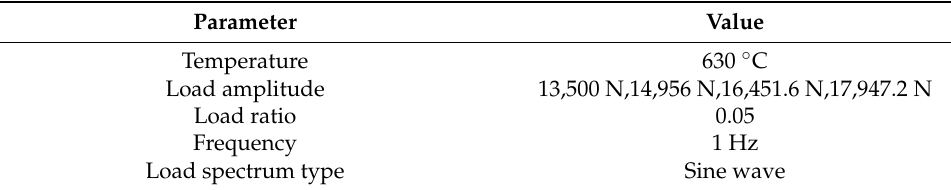
Table 3. Parameters for the fretting fatigue